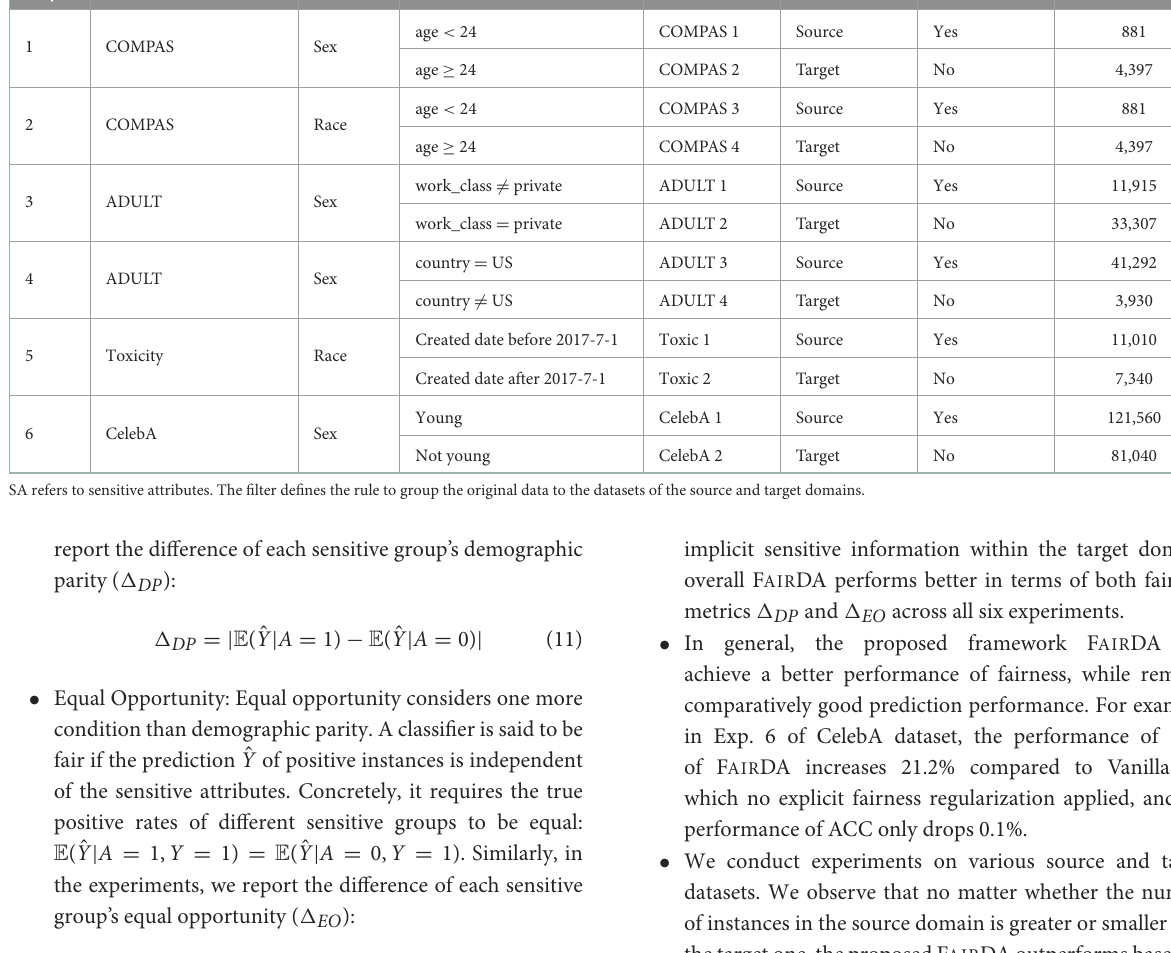
TABLE 1 Statistics of datasets.